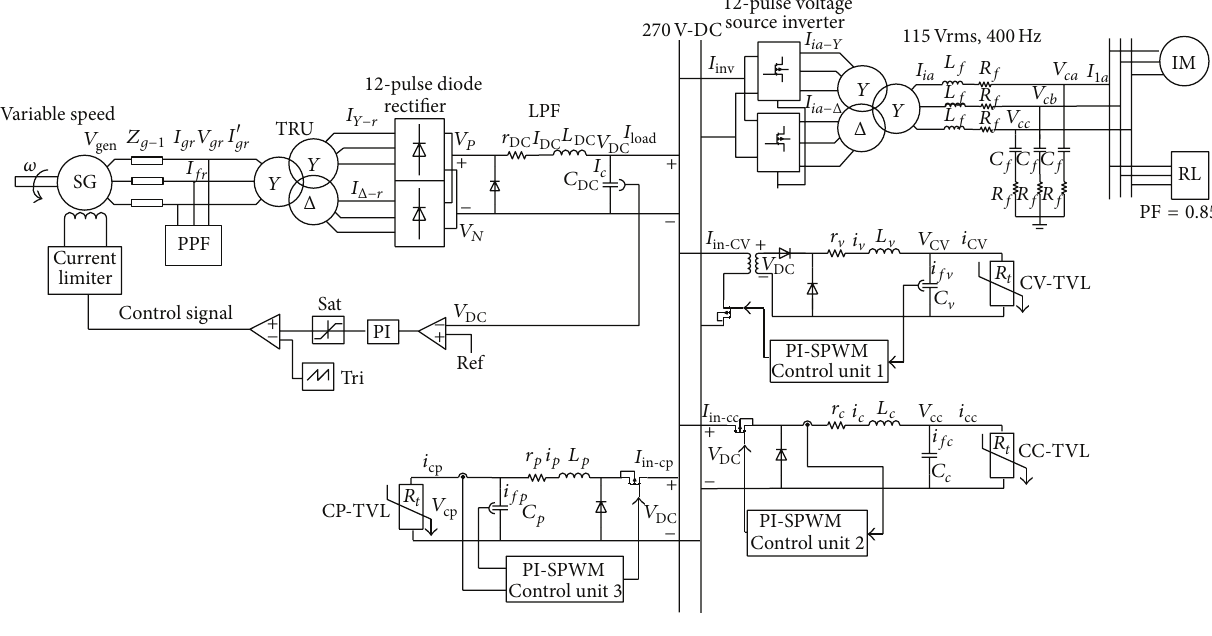
Figure 1: Schematic diagram of aircraft distribution system.